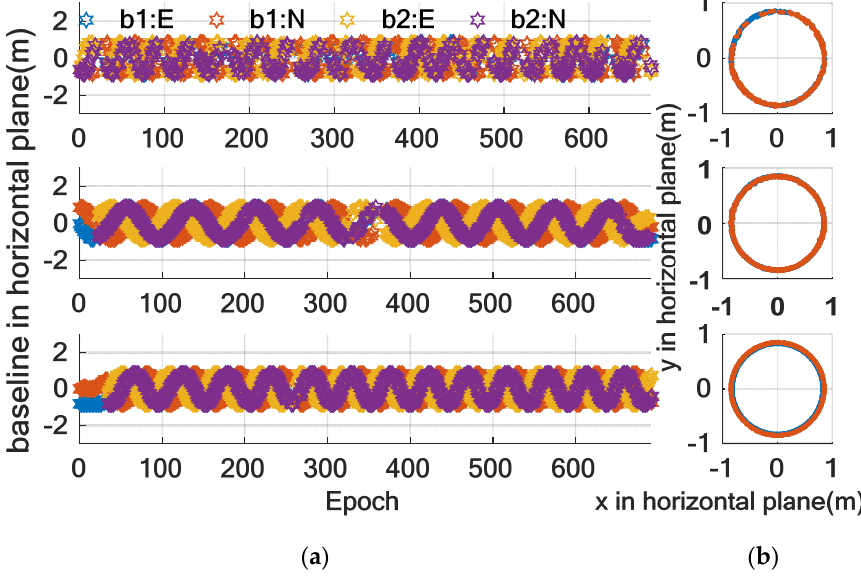
Figure 8. Dynamic experiment. ( a ) trajectory expressed in horizontal East–North coordinates as a function of time. The purple and red star lines are baseline one case, while the yellow and purple star lines are baseline two case. ( b )baseline solutions expressed in horizontal East–North plane, with blue line for rover 1 and red line for rover 2. The unit of the x-axis and y-axis is meters. Table 8. Euler success rate (correctly fixed) [%].